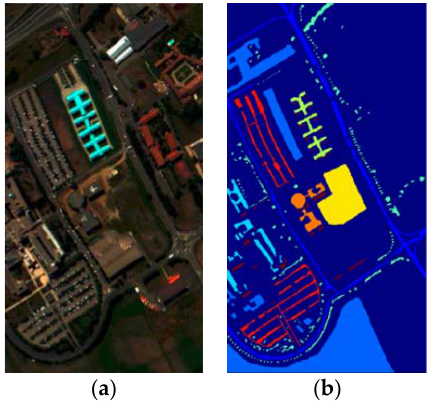
Figure 5. Pavia University data set. ( a ) False ‐ color image of Pavia University. ( b ) Ground ‐ truth map of Pavia University.